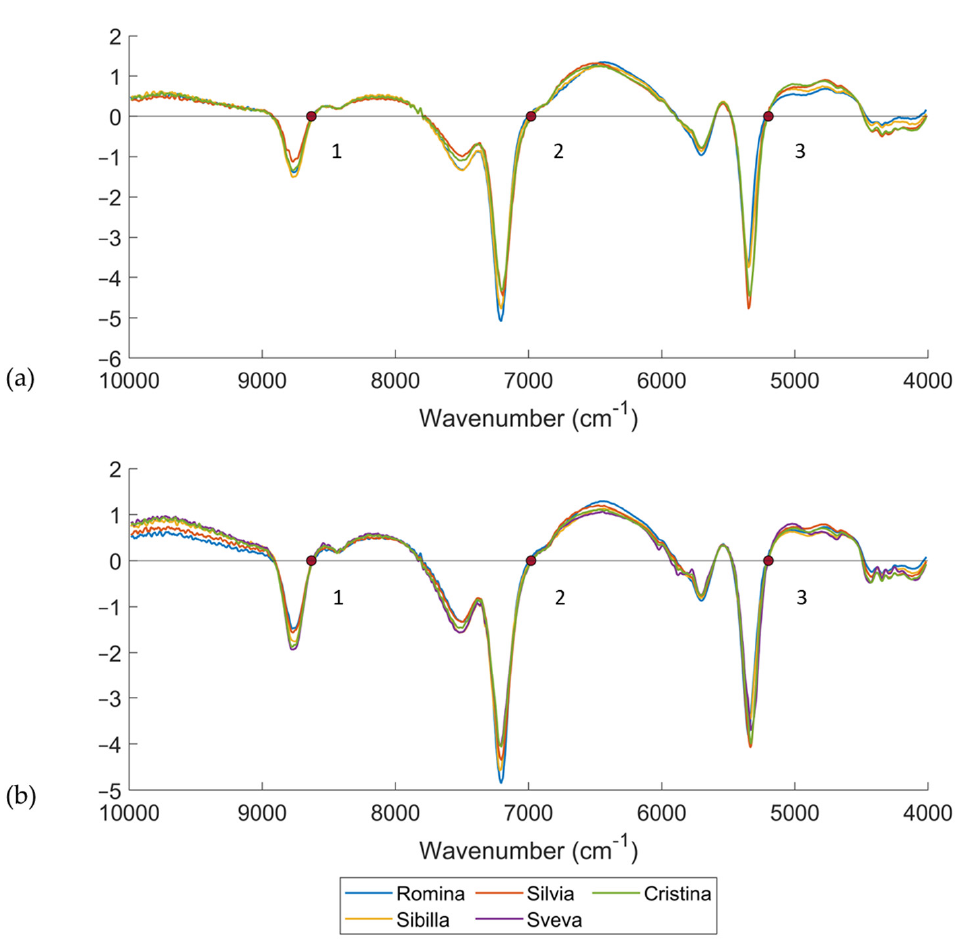
Figure 4. Average spectra of DB-2020 ( a ) and DB-2021 ( b ) cultivars pretreated using first derivative (Savitzky–Golay filter, 21 smoothing points, 2nd polynomial order) and SNV and considering only the first day of analysis i.e., the non-infected material/samples. The most important wavenumbers are marked with red dots.